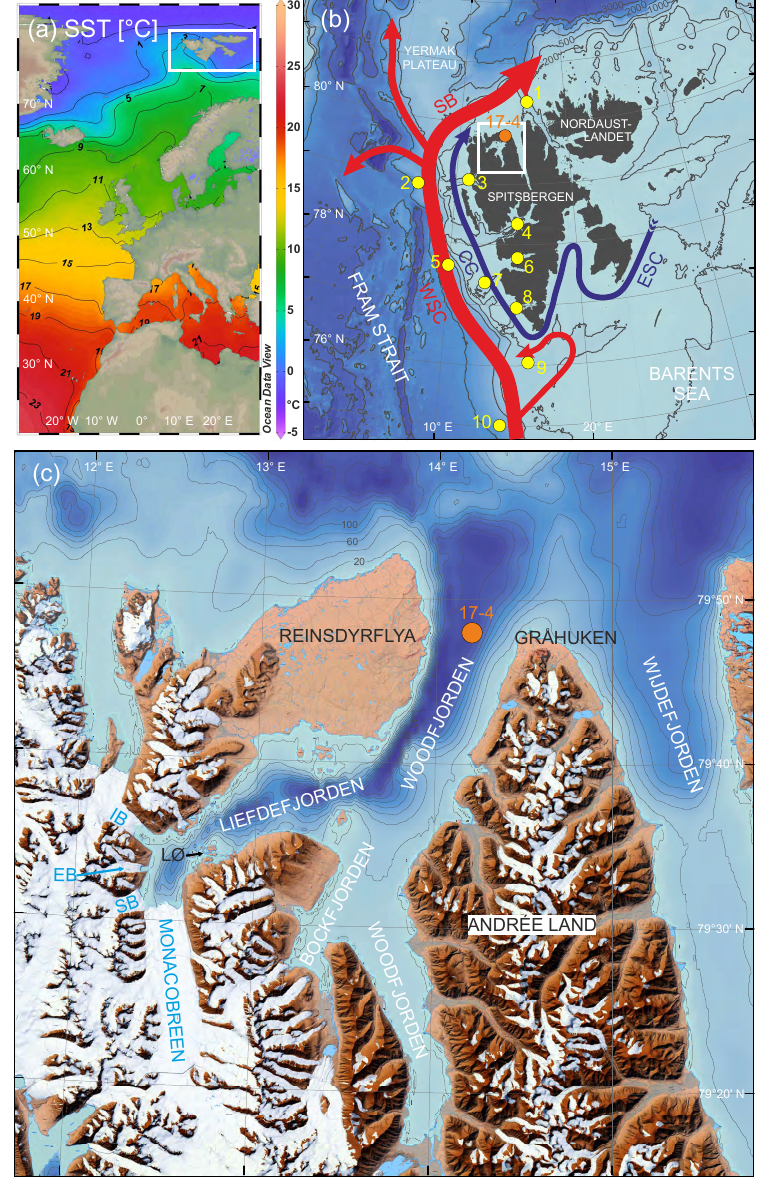
Figure 1. (a) Average annual (1955–2012) sea surface temperatures (SSTs) of the North Atlantic (World Ocean Atlas/Ocean Data View; Locarnini et al., 2013; Schlitzer, 2015). White rectangle: Svalbard area as shown in (b) . (b) Main ocean currents in the Svalbard area. Red arrows: Atlantic Water (WSC: West Spitsbergen Current; SB: Svalbard Branch). Blue arrows: Arctic Water (ESC: East Spitsbergen Current; CC: coastal current). The orange dot marks the study location (GeoB10817-4). Yellow dots mark other core sites mentioned in the